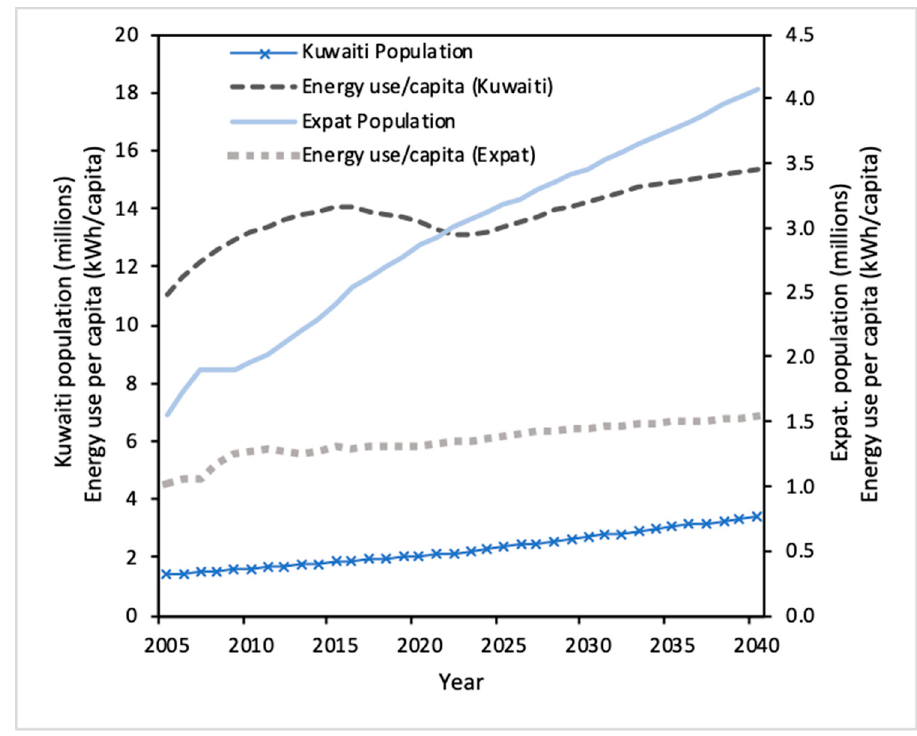
Figure 12. Forecast of population and residential energy consumption per capita.